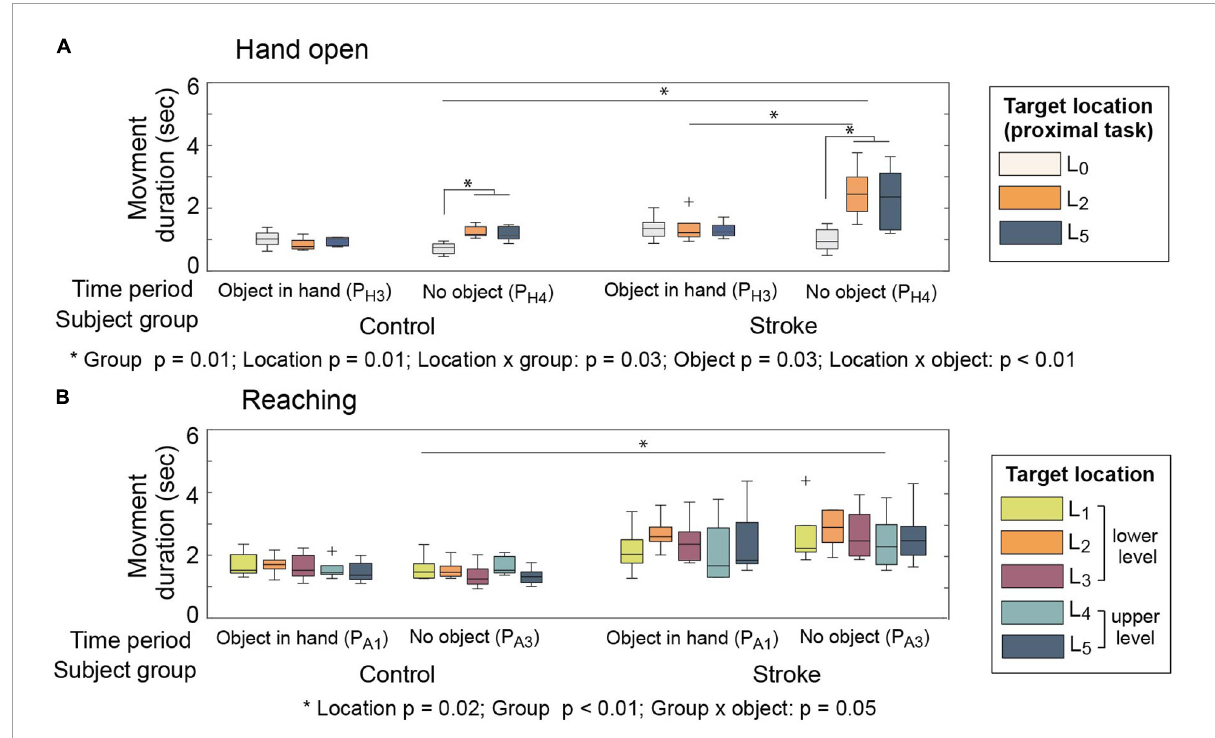
FIGURE8 Movement duration. (A) Hand movement (hand open). (B) Arm movement